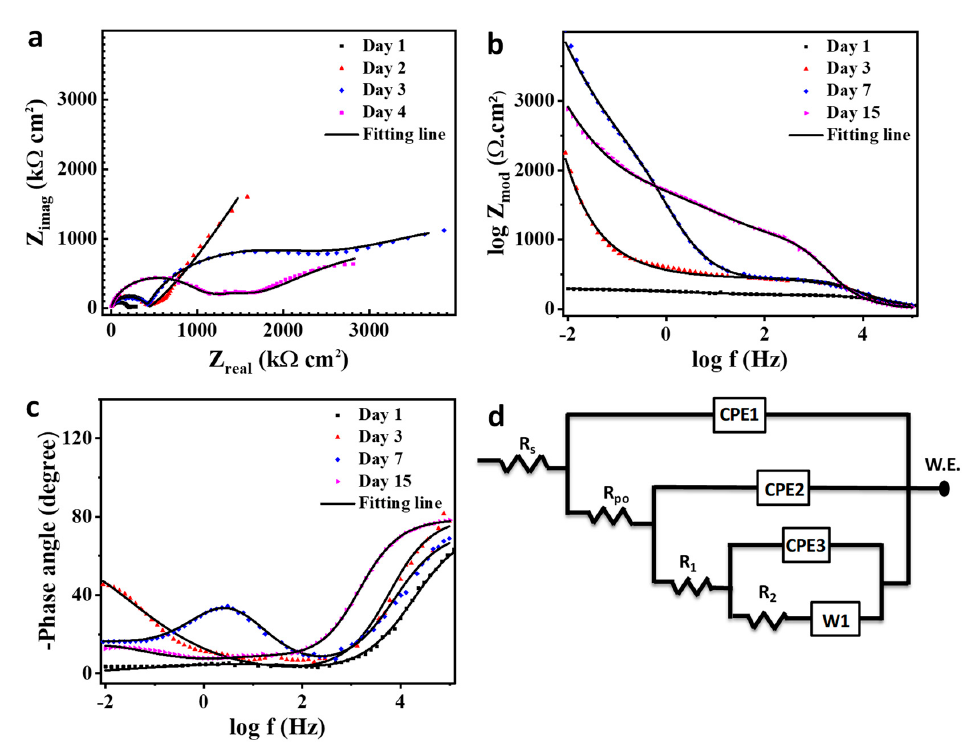
Figure 13. Electrochemical impedance curves for scratched smart coating immersed in 3.5 wt% NaCl for different exposure times: ( a ) Nyquist plot, ( b ) bode plot, ( c ) phase angle plot, and ( d ) the applicable equivalent circuit for the data fitting. Table 2. EIS parameters for neat coatings, plain coatings, and layered coatings in 3.5 wt% NaCl at room temperature.